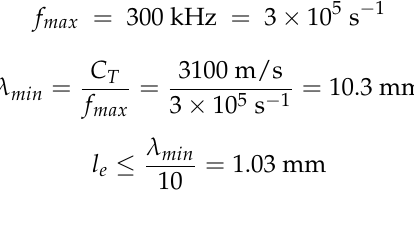
Figure 10. Meshing of the FEA model.